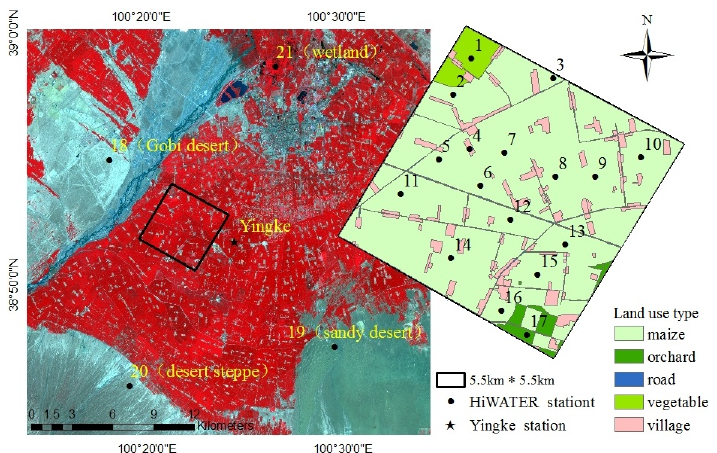
Figure 1. Spatial locations of the field observation stations in study area and land use map in the kernel experimental area. Table 1. Description of observation stations in the WATER and HiWATER